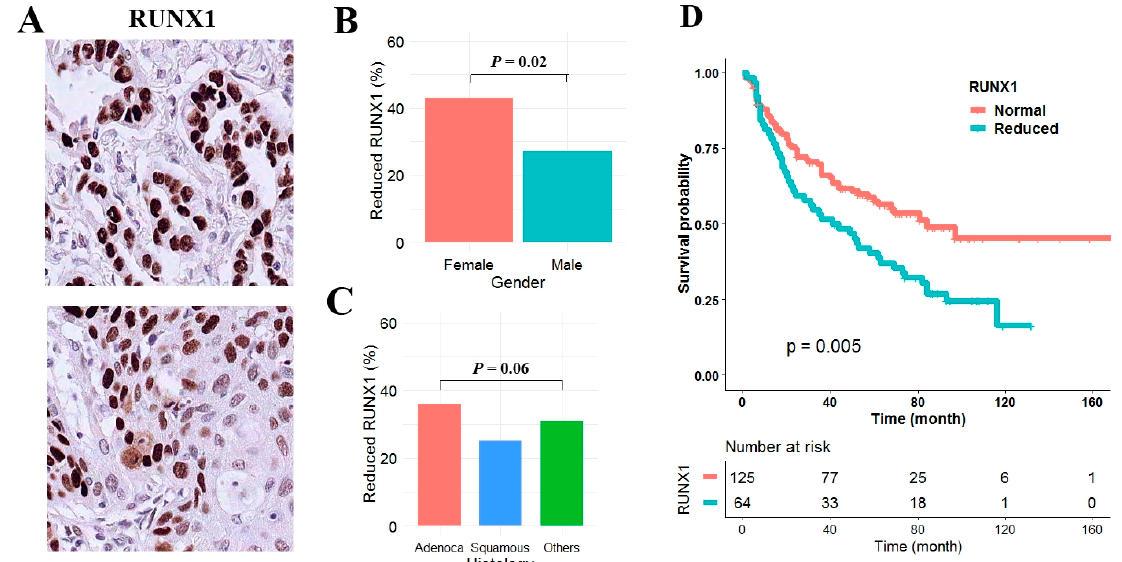
Figure 4. The e ff ect of RUNX1 expression on overall survival in NSCLC. ( A ) RUNX1 expression was analyzed using immunohistochemistry in 409 NSCLC patients. Positive staining occurred in the nucleus of adenocarcinoma (upper) and squamous cell carcinoma. (X200). ( B , C ) Reduced expression levels were compared according to gender ( B ) and histologic subtypes ( C ). p -values are based on Student t -test. ( D ) The e ff ect of reduced RUNX1 expression on overall survival of patients with adenocarcinoma was analyzed using Kaplan-Meier survival curve. p -value was calculated using log-rank test. Table 1. Cox proportional hazards analysis of overall survival according to RUNX1 expression. Histology